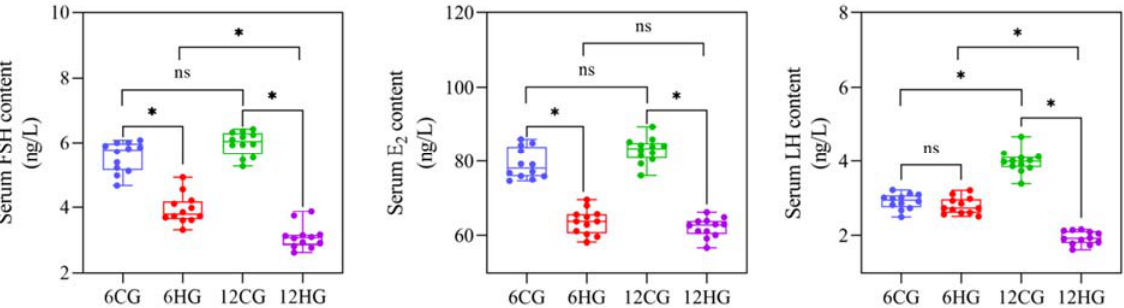
Figure 2. Serum FSH, E 2 , and LH contents in Nile tilapia ( Oreochromis niloticus ) under heat stress ( n = 12). Note: * indicates statistical significance between heat-stressed group and control group ( p < 0.05). ns indicates no statistical significance.